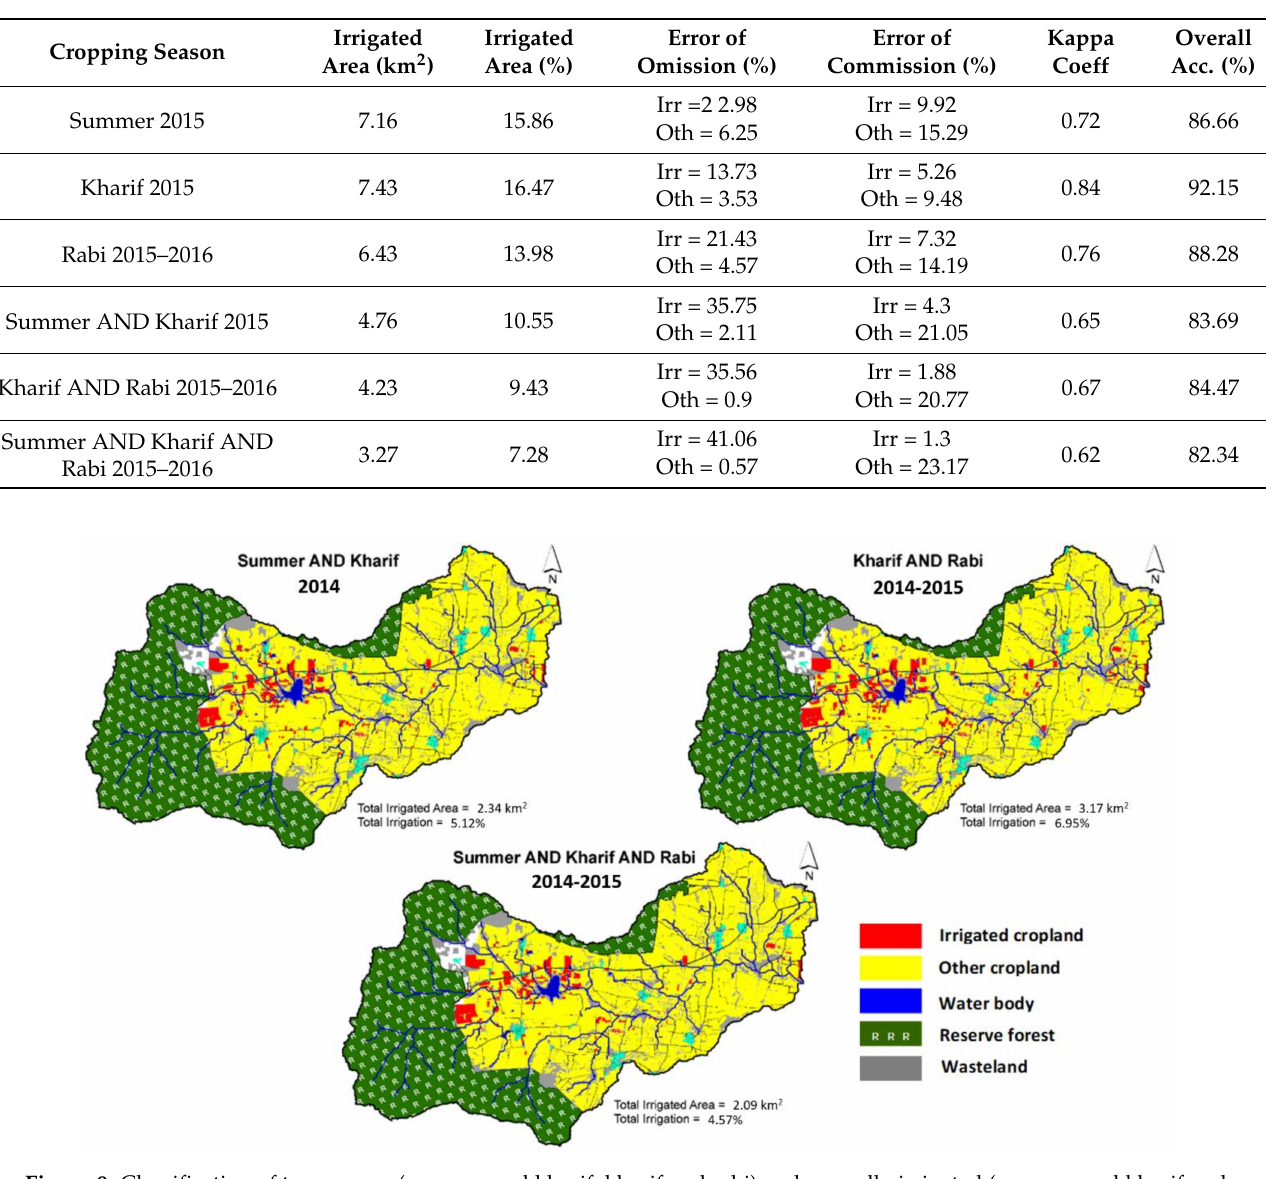
Table 3. Classification accuracy of intensively irrigated cropland (Irr; intensive irrigation) and other croplands (Oth; rainfed, fallow, and partial irrigation in the absence of rainfall) for 2015–2016.